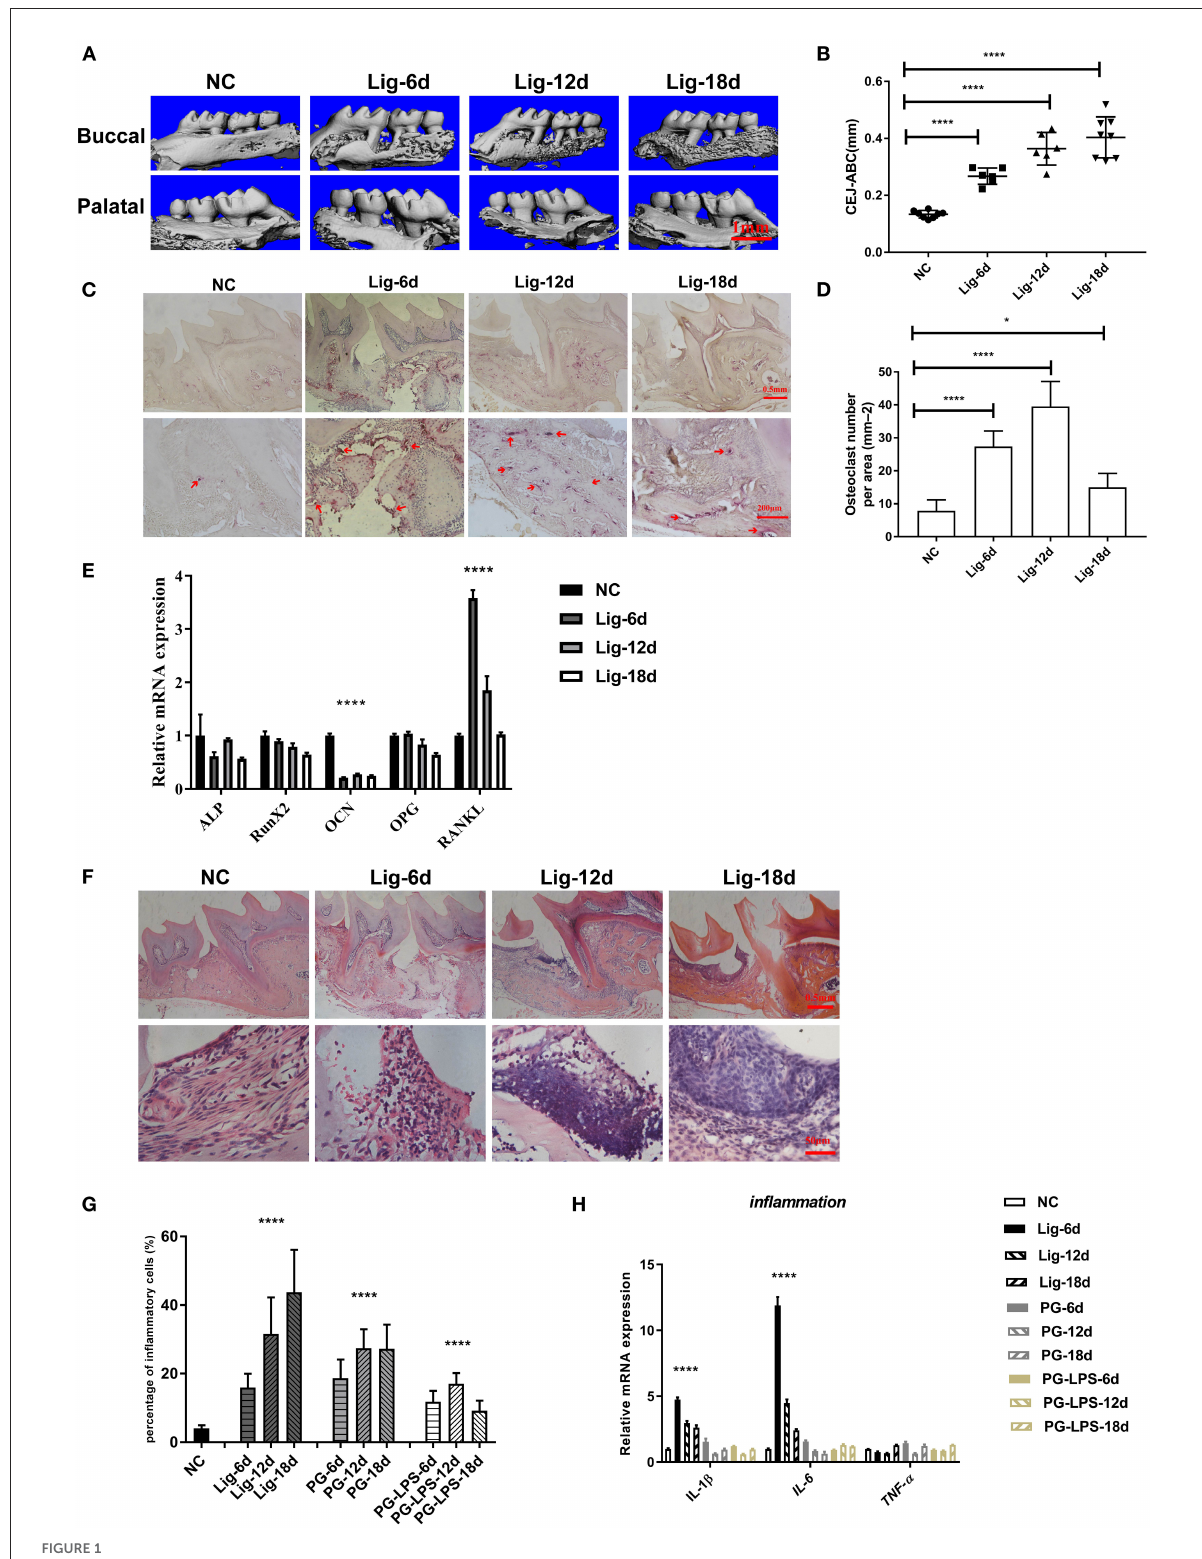
FIGURE1 Orthodontic wire ligature induces progressive alveolar bone resorption and inflammatory response. (A) Representative sagittal 3D images viewed from the buccal side and palatal side of the maxillary molars using Micro-CT, scale bar, 1mm. (B) CEJ-ABC linear